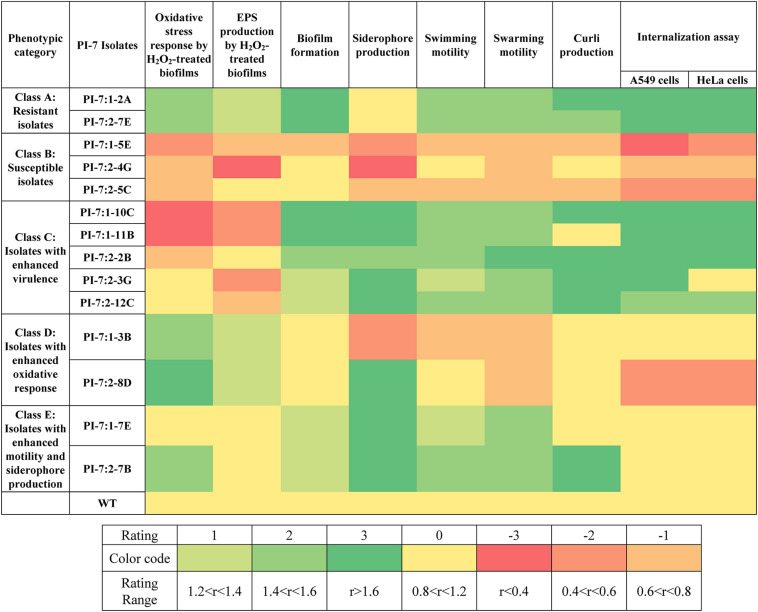
Phenotypic traits with respect to oxidative stress response and virulence traits displayed by selected E. coli PI-7 random transposon insertion site mutants relative to WT. Relative phenotypic traits higher than WT are shown in green. Rating of 3 indicates relative phenotypic traits >1.6-folds (p < 0.05), 2 indicates relative phenotypic trait between 1.4 and 1.6-folds (p < 0.05) and 1 indicates relative phenotypic traits between 1.2 and 1.4-folds (p < 0.05). Relative phenotypic traits lower than WT is shown in orange. Rating of -3 indicates relative phenotypic traits <0.4-folds (p < 0.05), –2 indicates relative phenotypic trait between 0.4 and 0.6-folds (p < 0.05) and -3 indicates relative phenotypic trait between 0.6 and 0.8-folds (p < 0.05). Relative phenotypic traits exhibiting no significant differences relative to WT are shown in yellow. Based on the phenotypic traits relative to WT, mutants are classified into five categories, namely class A (includes mutants with enhancement in nearly all examined phenotypic traits), class B (includes mutants with decrease in all examined phenotypic traits), class C (includes mutants with enhanced virulence traits), class D (includes mutants with enhanced oxidative stress response) and class E (includes mutants with enhanced motility and siderophore production).